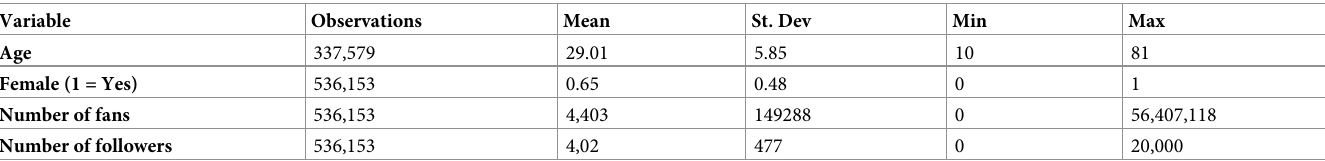
Table 1. Collected Weibo user statistical